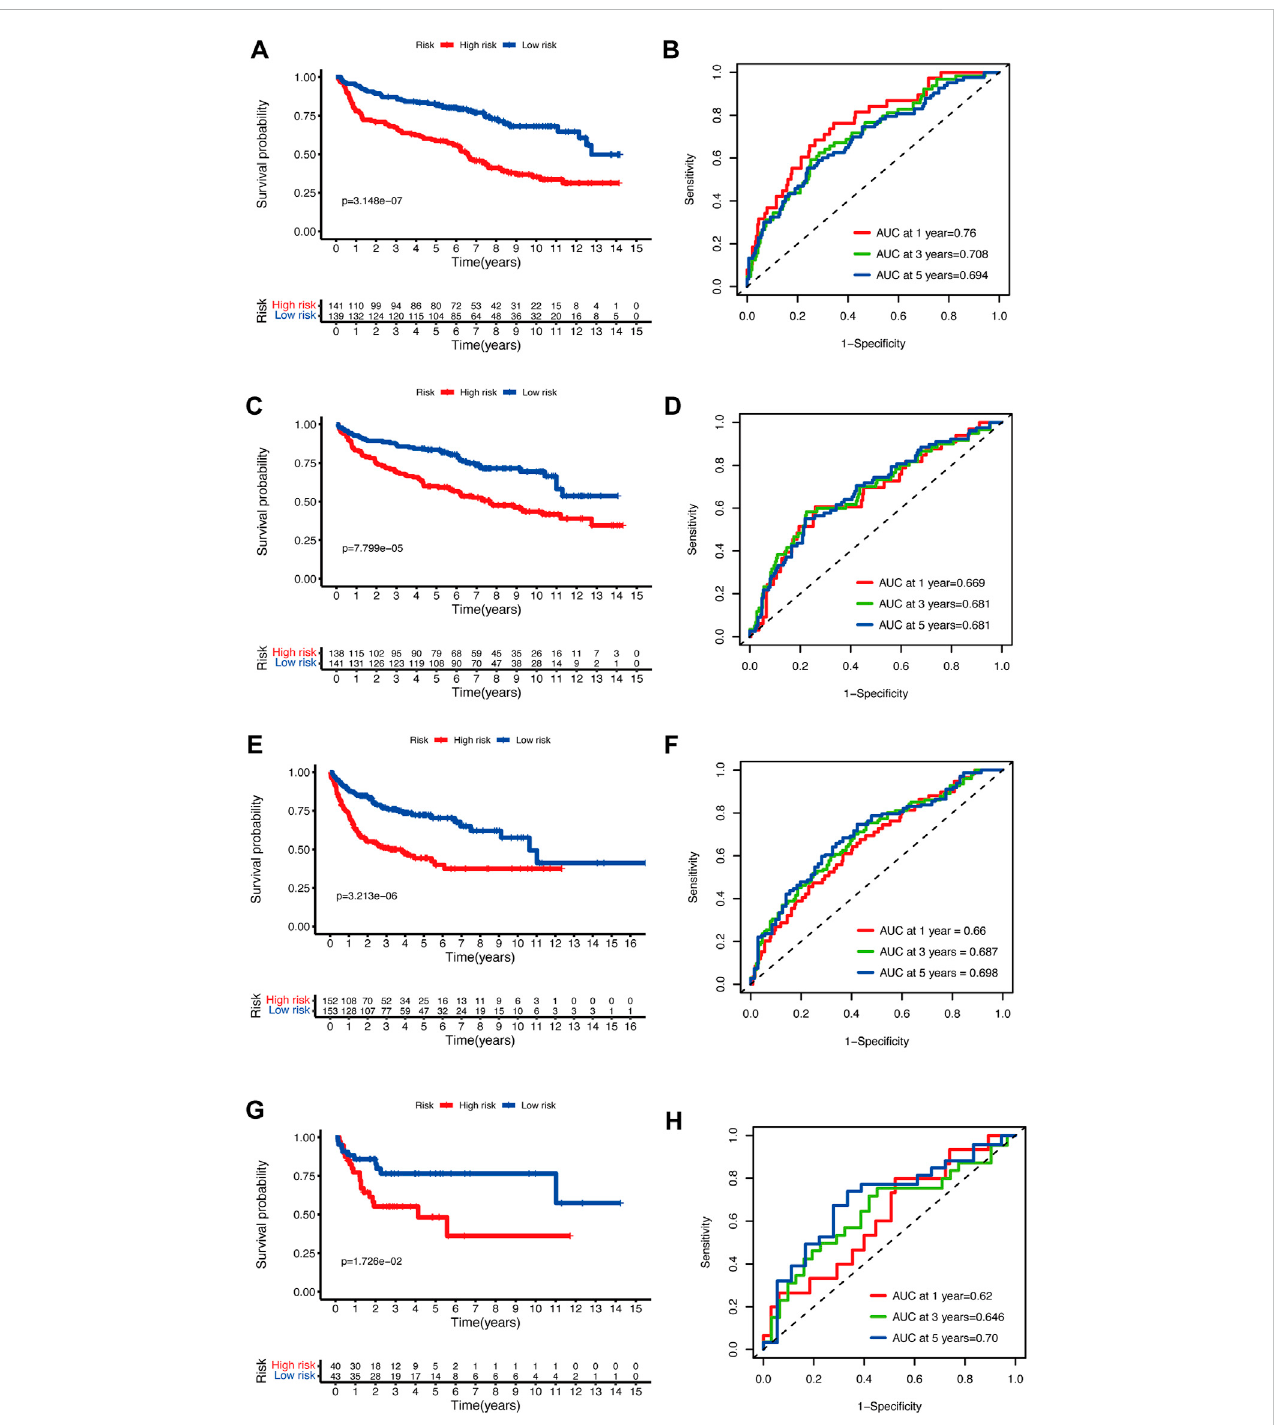
FIGURE 3 Validationoftheglycolyticriskmodel. Kaplan-Meier analysesofoverall survivalfor patients in high- andlow-riskgroupsin internal validationcohorts (A, C) , GSE10846 (E) , and GSE53786 (G) . Time-dependent ROC analyses of the risk model in internal validation cohorts (B, D) , GSE10846 (F) , and GSE53786 (H) . ROC, receiver operating characteristic.